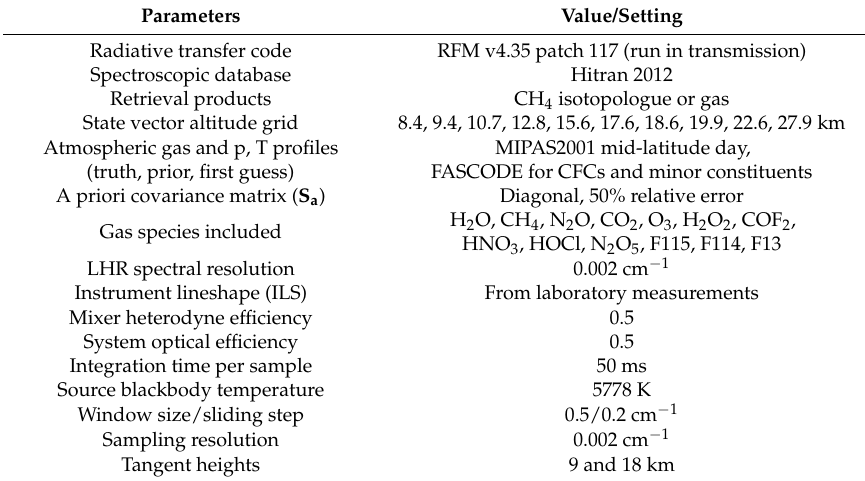
Table 1. Parameters used in the OSS used for sliding window analysis, for a limb observer at 1000 km